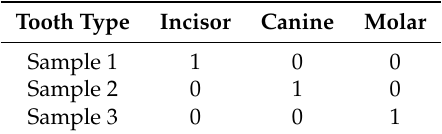
Table 1. One-hot encoding for tooth types.